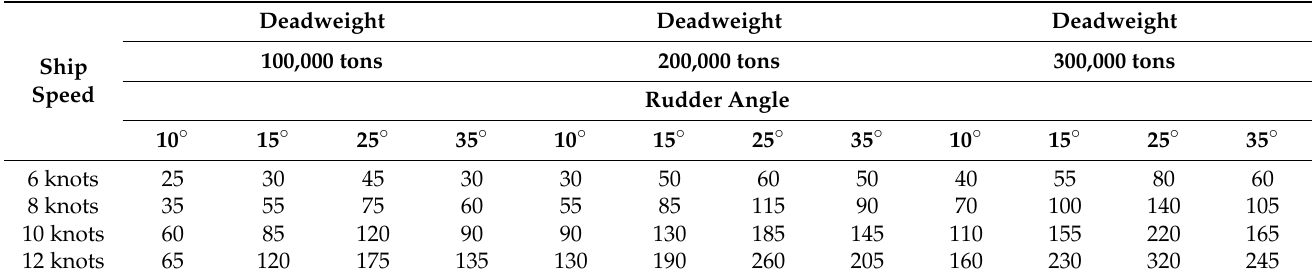
Table 4. TSP data in tons of different tanker vessels.